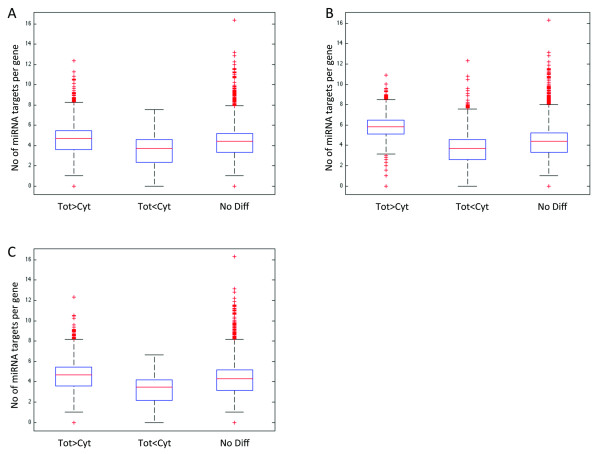
Boxplot showing the number of microRNA targets per gene for all three cell lines separately. Genes detected at a significantly higher level in total RNA than in cytoplasmic RNA (Tot>Cyt), lower level (Tot<Cyt), and genes with no significant differential detection (No Diff). A: A-431. B: U-2 OS. C: U-251 MG.